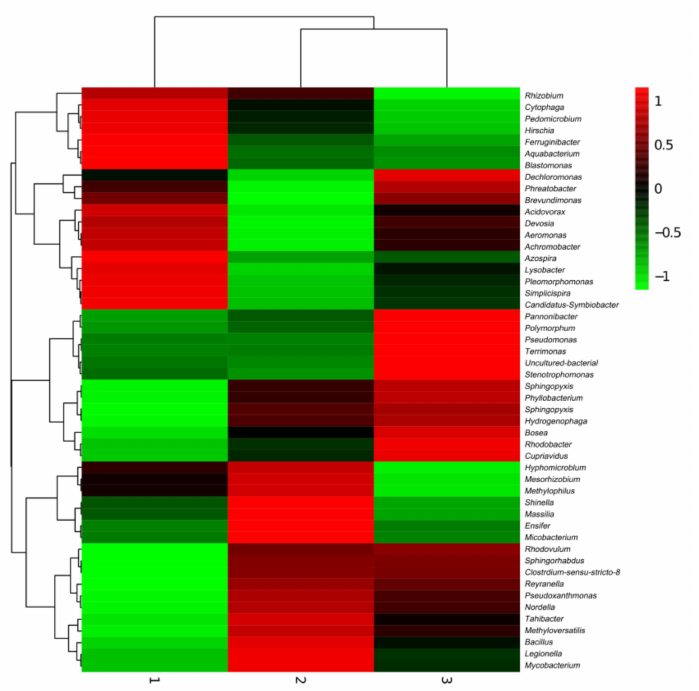
Figure 7. Generic level community composition heat map with cluster analysis. Samples are first clustered according to their composition similarity and then arranged horizontally according to the clustering results. Similarly, taxa are also clustered according to their distribution similarity in different samples and are arranged vertically according to the clustering results. In the figure, red represents the genera with high abundance in the corresponding sample, and green represents the genera with low